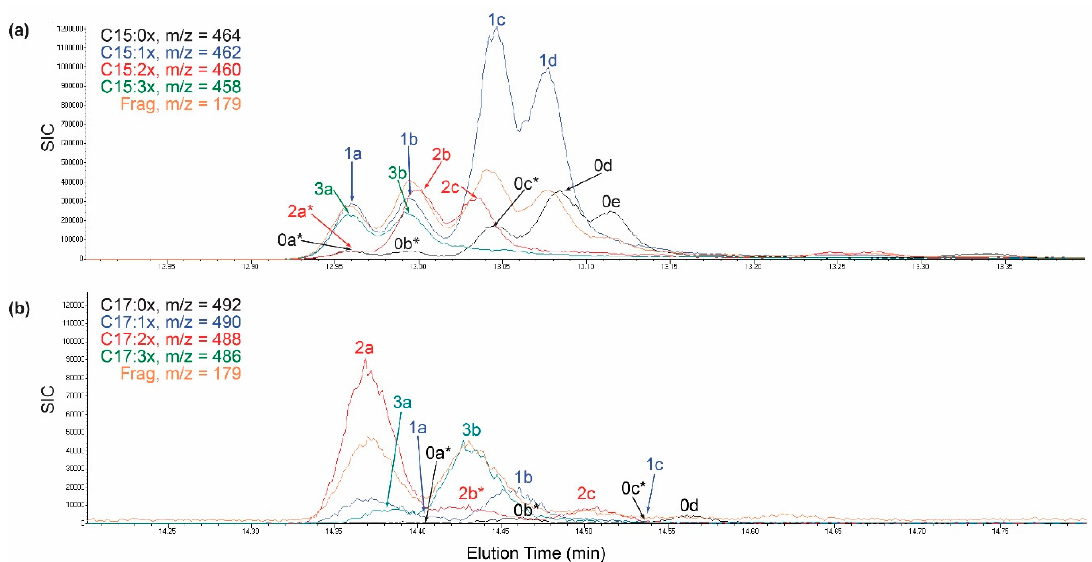
Figure 2. GC-MS selective ion chromatograms for C15- and C17-urushiol congeners and isomers. ( a ) sample C15-urushiol chromatogram. ( b ) sample C17-urushiol chromatogram. Numbers indicate the degree of unsaturation, and letters indicate unique isomer of the specified congener. Asterisk